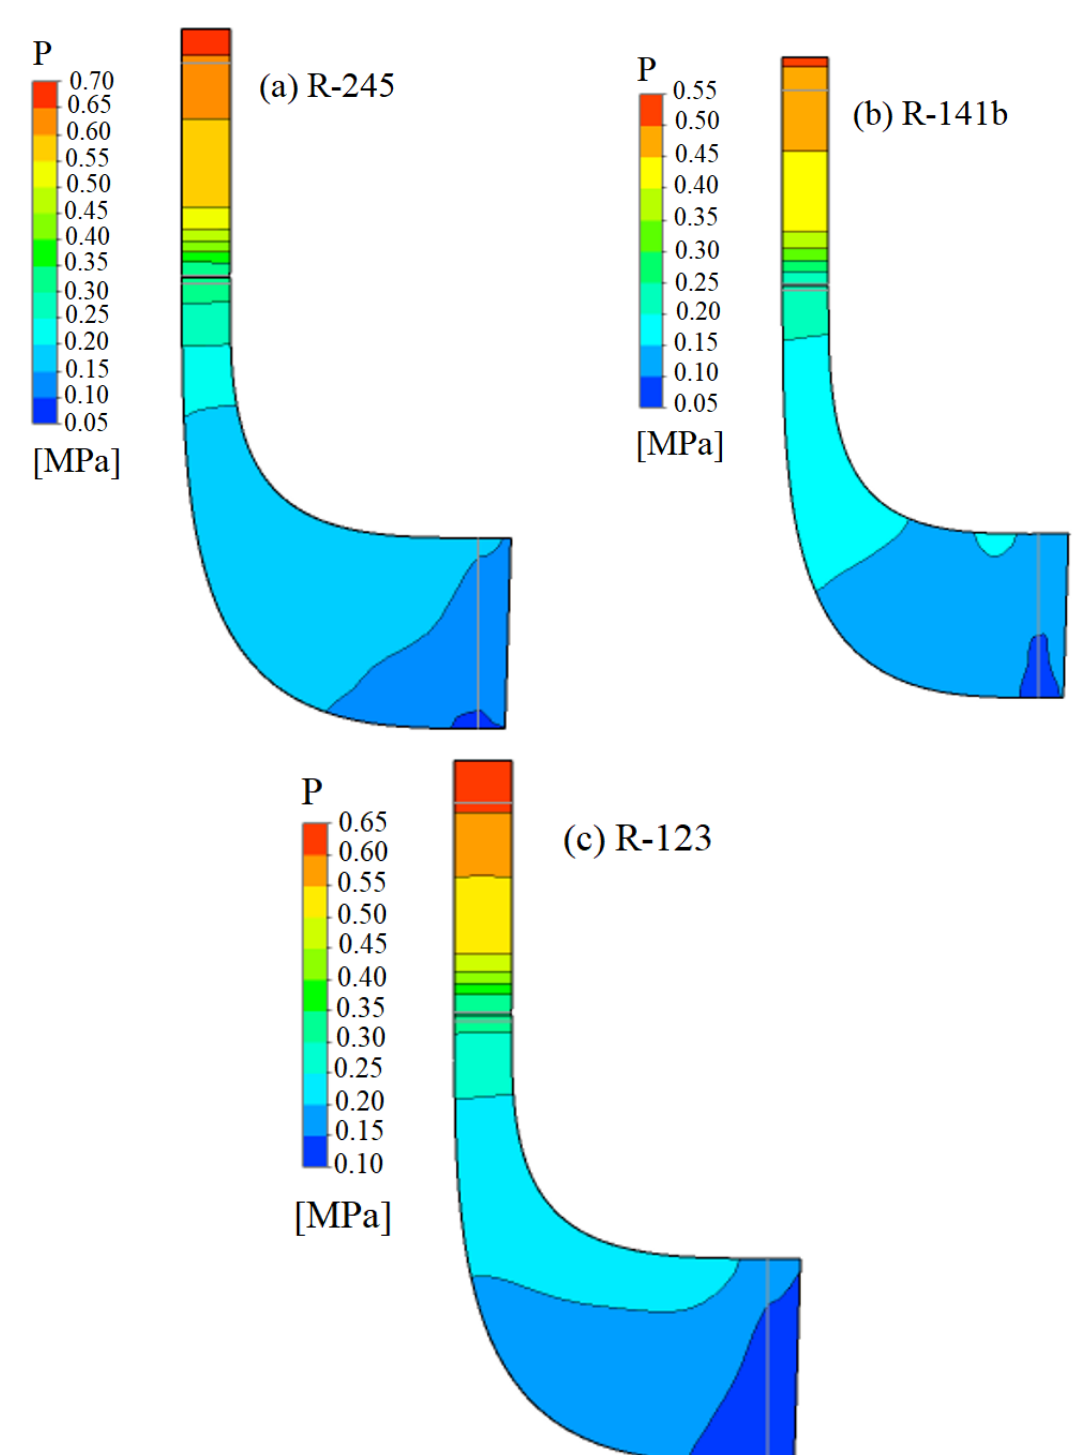
Figure 9. Pressure boundaries in the meridional plane of the radial turbine nozzle ‐ rotor set.